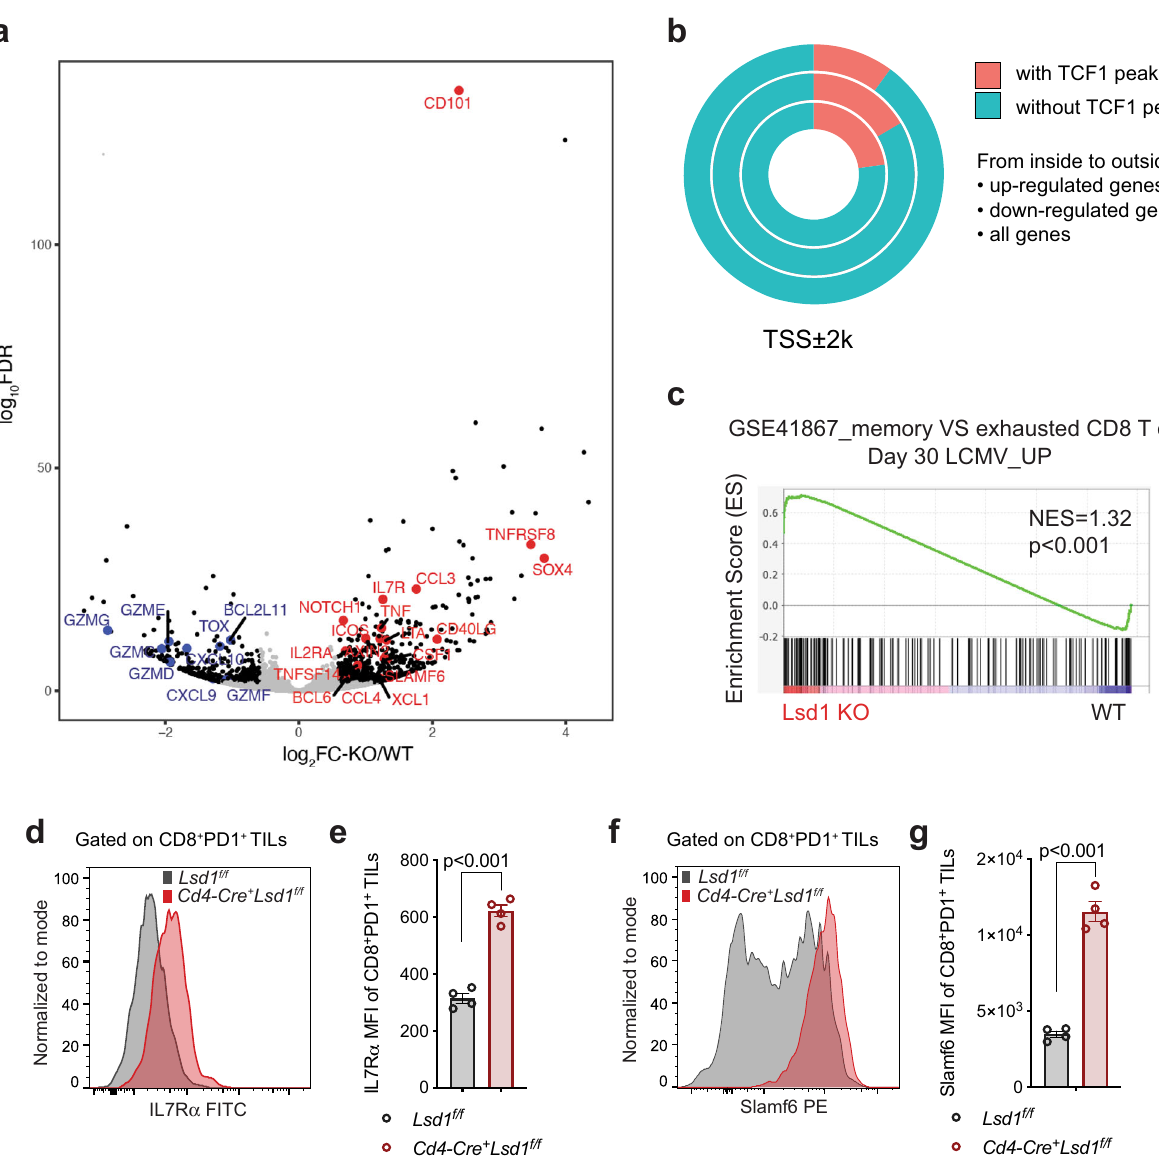
Fig. 6 LSD1 loss unleashes TCF1-controlled gene expression in CD8 + TILs. a A volcano plot showing differential gene expression by LSD1-de fi cient versus wildtype CD8 + CD44 + PD-1 + TILs of MC38 tumors ( n = 4 per group, FC > 1.5 and FDR < 0.01 as the cutoff). Non-gray colored dots mean signi fi cant difference. b Percentages of genes bound by TCF1 among the differentially expressed genes in LSD1-de fi cient versus wildtype CD8 + TILs or among total genes in genome. c GSEA analysis in Lsd1 KO versus WT CD8 + TILs ( n = 4 per group). Gene list was ranked with signed (from log 2 FC) likelihood ratio from Lsd1 KO versus WT comparison. Kolmogorov – Smirnov test was used to determine the enrichment score. d , e A representative fl ow plot of IL7R α expression ( d ) and IL7R α MFI ( e ) of MC38 tumor-in fi ltrating CD8 + PD-1 + T cells ( n = 4 per group). f , g A representative fl ow plot of Slamf6 expression ( f ) and Slamf6 MFI ( g ) of MC38 tumor-in fi ltrating CD8 + PD-1 + T cells ( n = 4 per group). Data represent two independent experiments ( d – g ) and are presented as mean ± SEM ( e , g ). Statistical signi fi cance was determined by two-sided unpaired t test ( e , g ). Source data are provided as a Source data fi